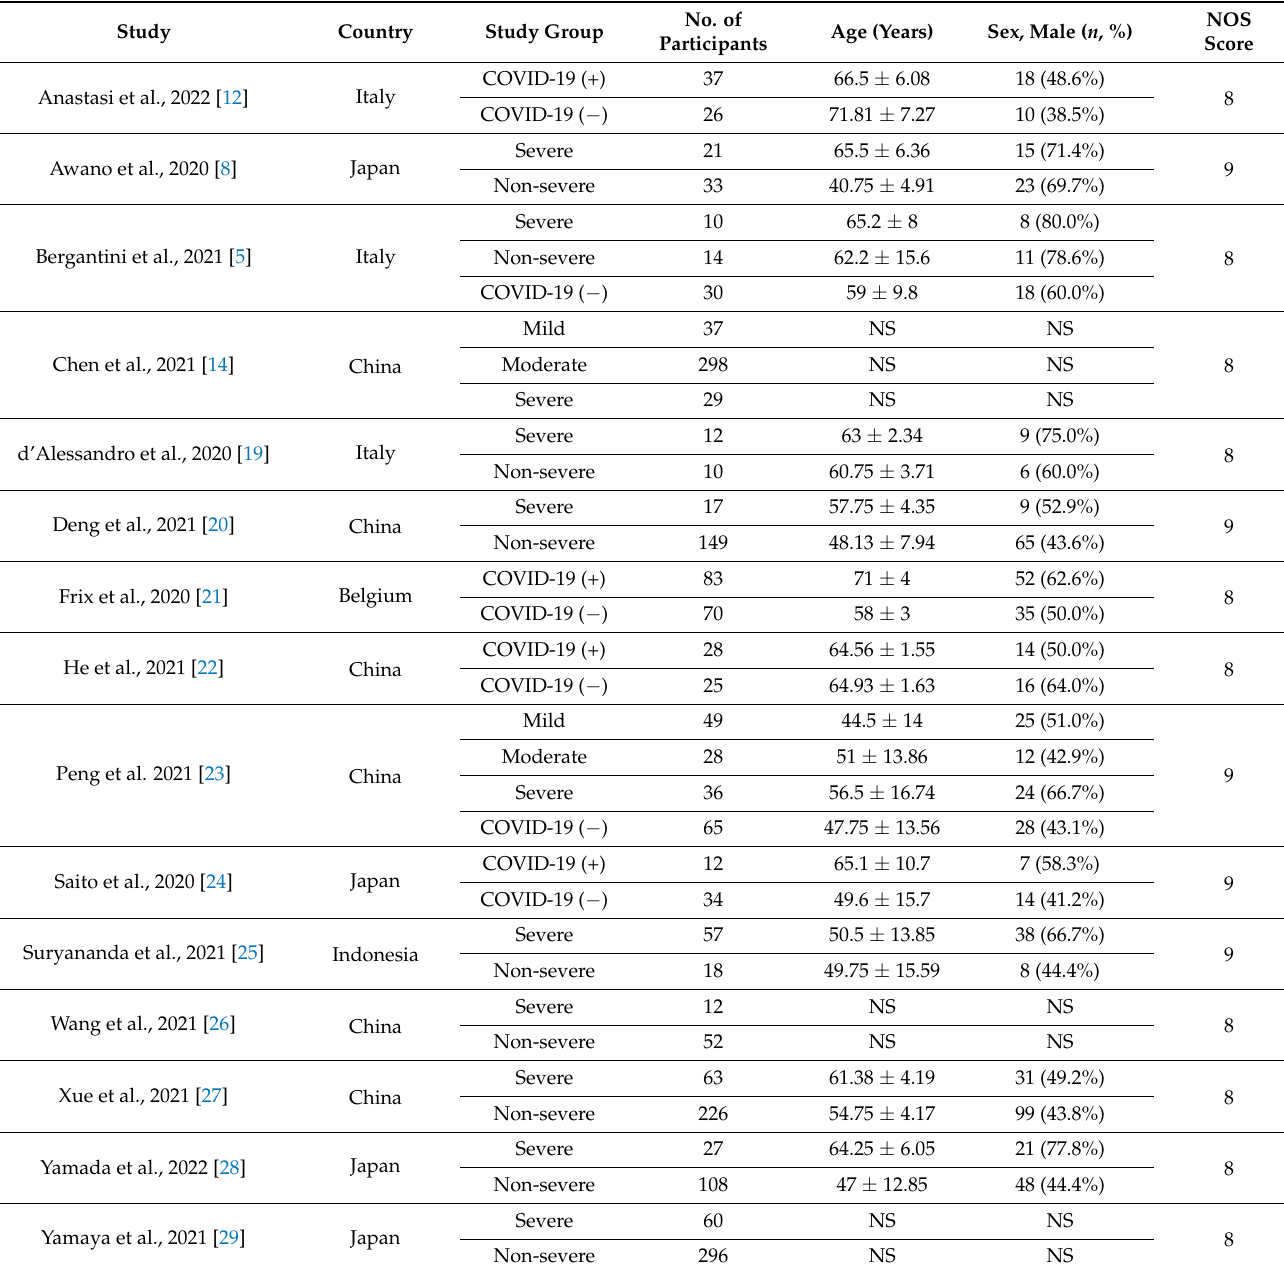
Table 1. A summary of study